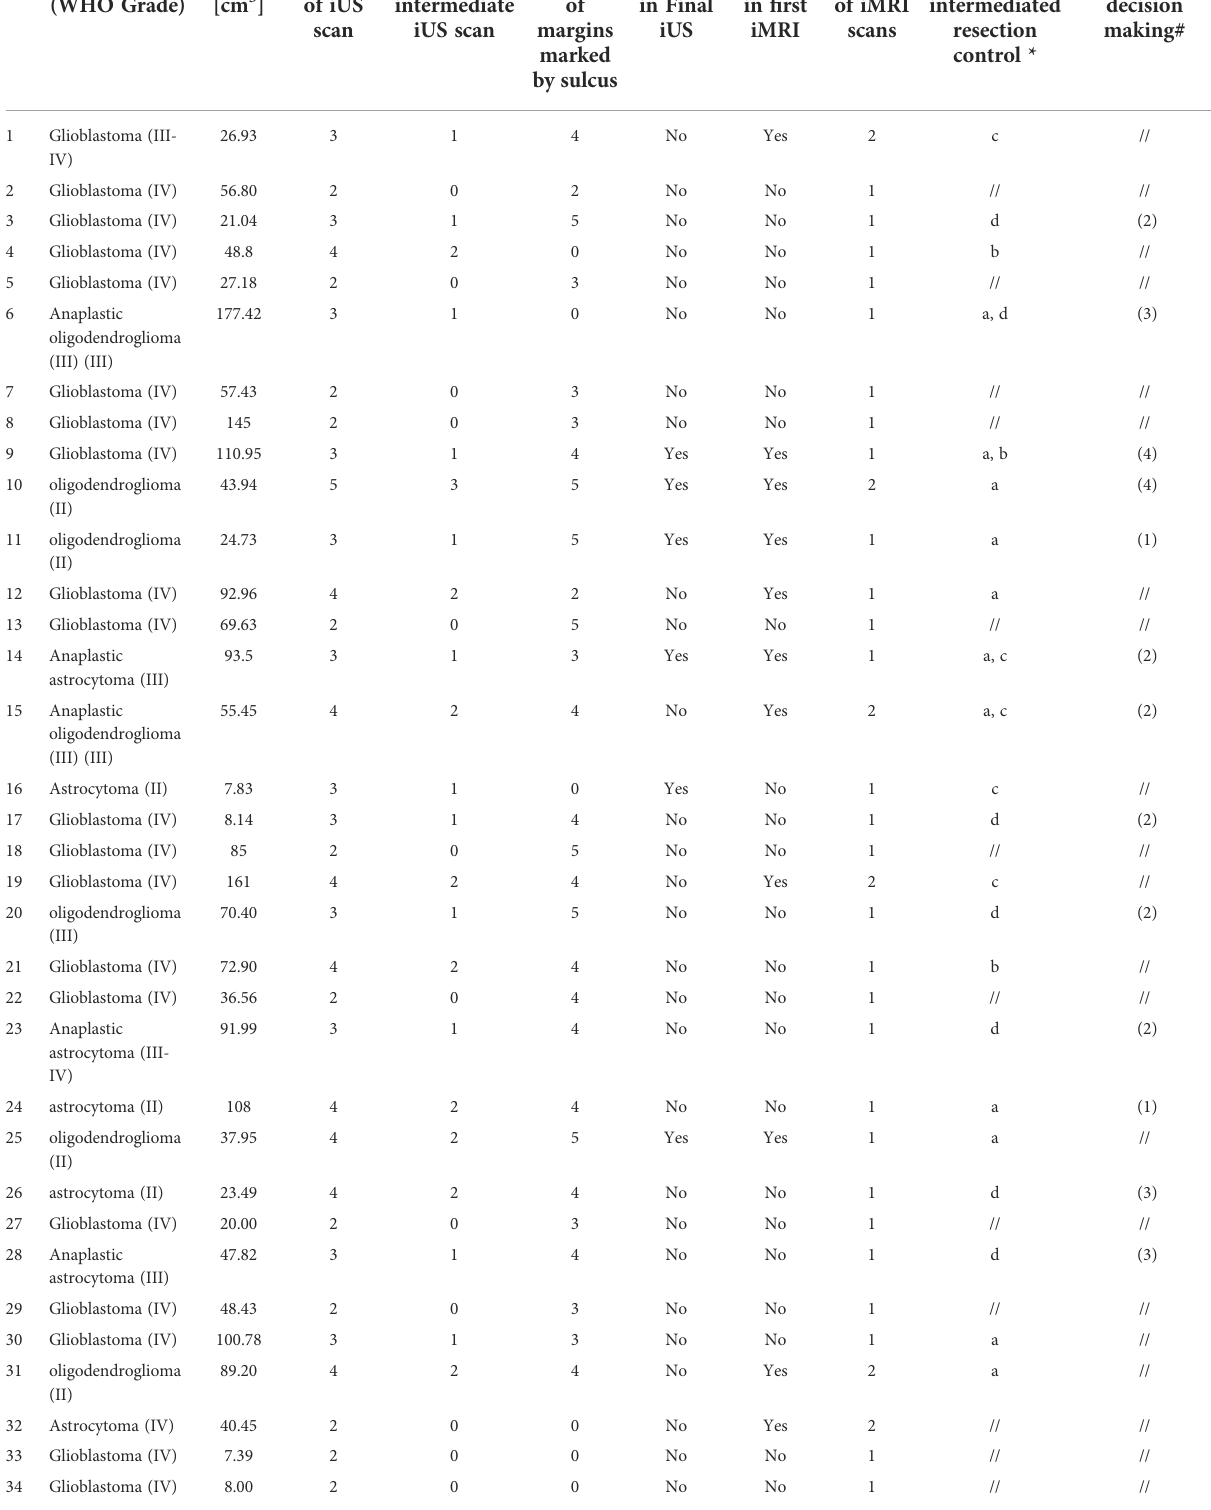
TABLE 2 iUS and iMRI fi